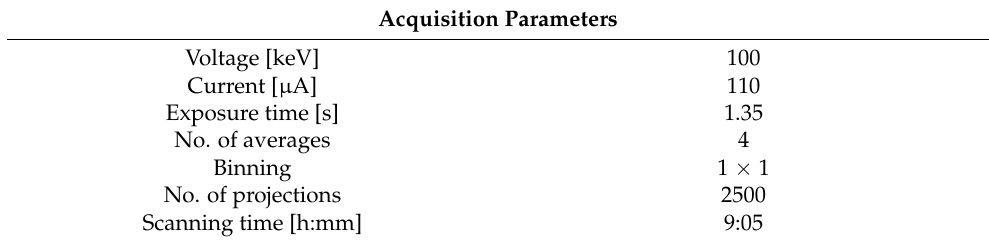
Table 2. Scanning conditions of the scanned flake graphite ore sample.